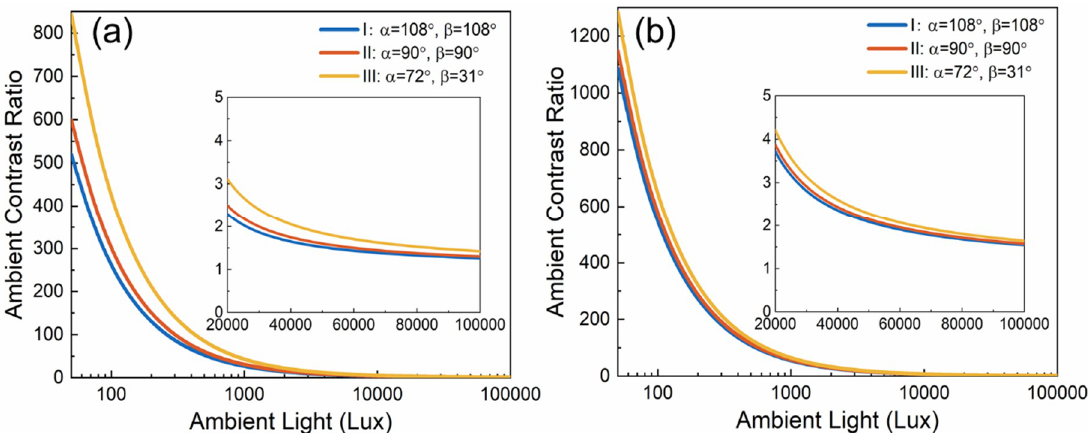
Figure 8. Simulated ambient contrast ratio of structure I, II and III: ( a ) without AR (anti-reflection ) coating (surface reflection ~4%), and ( b ) with AR coating (surface reflection ~0.2%).